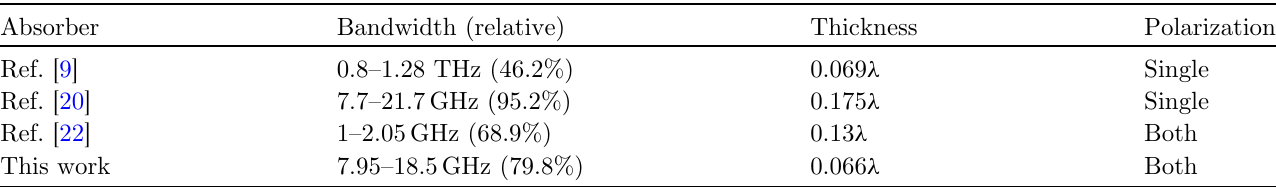
Table 1. Comparison with other